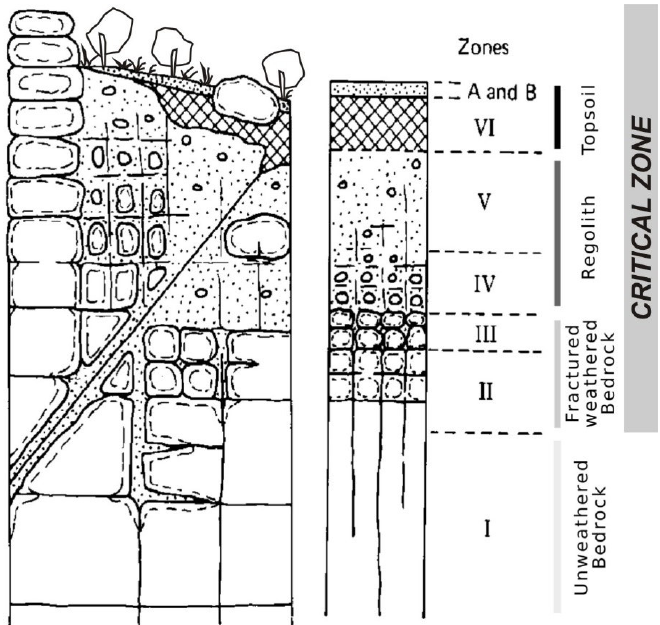
Figure 1. Simplified model of the critical zone regarding the weathering profile developed on rock masses [modified from 18,19,20]. Zones I to VI defined by the degree of weathering [18]. masses (modified from [18–20]). Zones I to VI defined by the degree of weathering